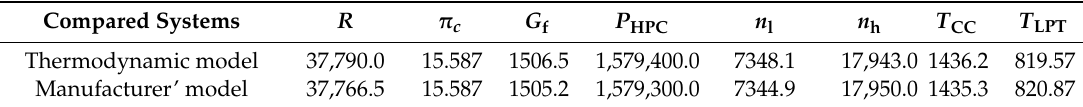
Table 2. Thermodynamic model validation